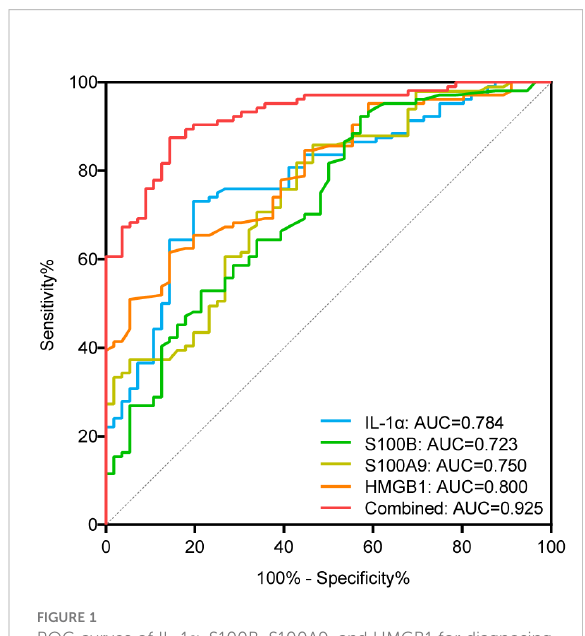
FIGURE 1 ROC curves of IL-1 a , S100B, S100A9, and HMGB1 for diagnosing vitiligo. AUC indicates the area under the receiver operating characteristic curve. The blue, green, yellow, orange curve represents the ROC curve of IL- a , S100B, S100A9, and HMGB1, respectively; the red curve represents the ROC curve of the combination of IL-1 a , S100B, S100A9, and